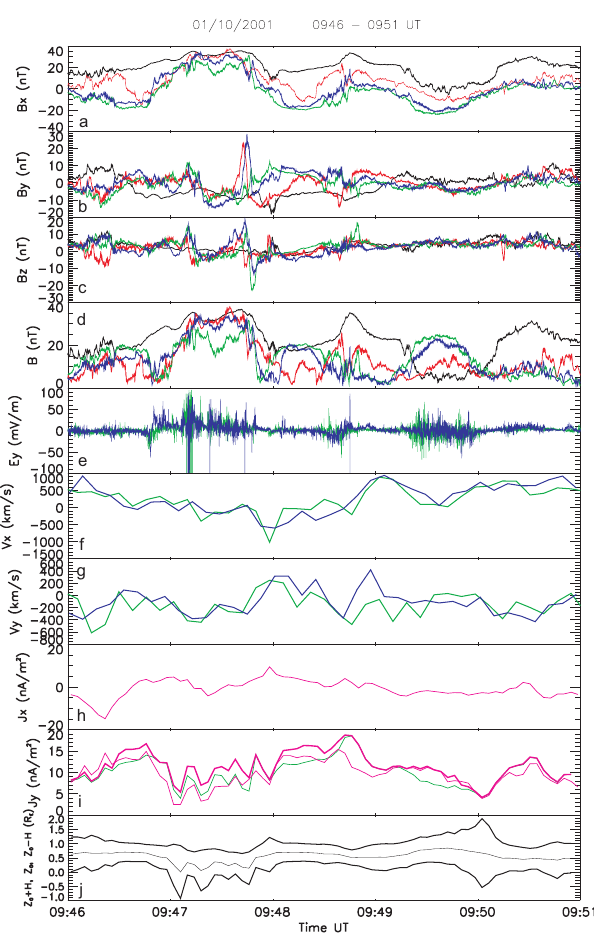
Fig. 14. (Flow reversal. Same format as Fig. 11. For this event B L =40nT. The parameters of the Harris sheet are determined from B x measured by S/C 1 and 3, at different Z and similar X and Y . Panel (i) shows the two independent time profiles of J , estimated from Harris fit (thick pink,) and from curlB (thin pink). The green line is for J at S/C3, from Harris fit. CS parameters ( H and Z 0 ) are determined from S/C 3 and 4. Data displayed in panels (f, g, i, j) are deduced from CIS/CODIF. Here time resolution of CIS data is